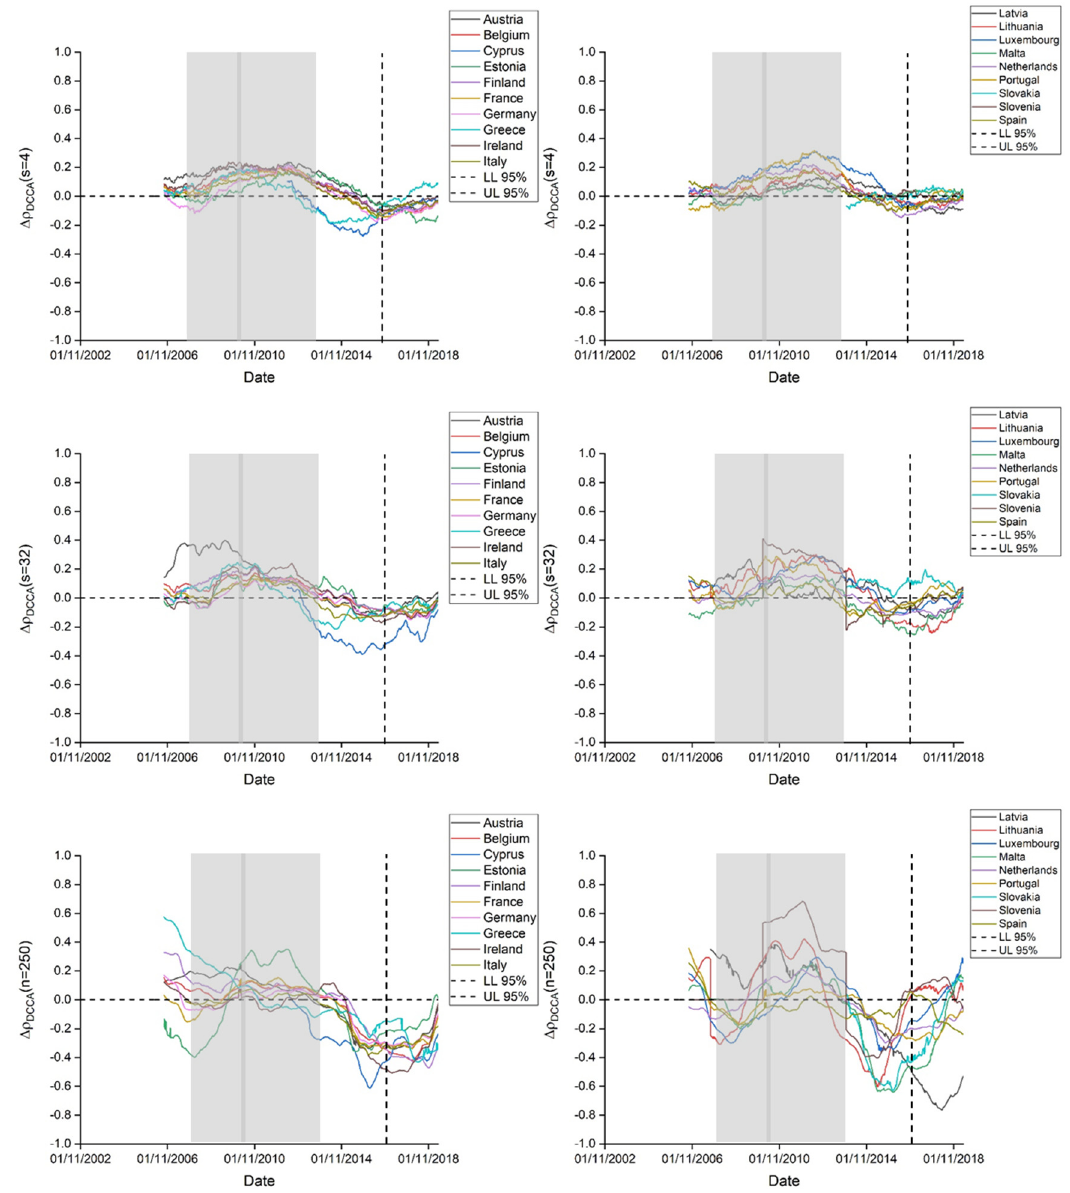
Figure 7. Evolution of the ∆ ρ DCCA between Eurozone stock markets and the US for time scales of 4, 32, and 250 days, considering that ∆ ρ DCCA ( 1 ) = ρ DCCA ( 1001 ) − ρ DCCA ( 1 ) . LL and UL are, respectively, the lower and upper limits of the confidence interval. Shaded areas represent the global financial crisis and the Eurozone debt crisis. The vertical dashed line refers to the moment of the Brexit referendum.